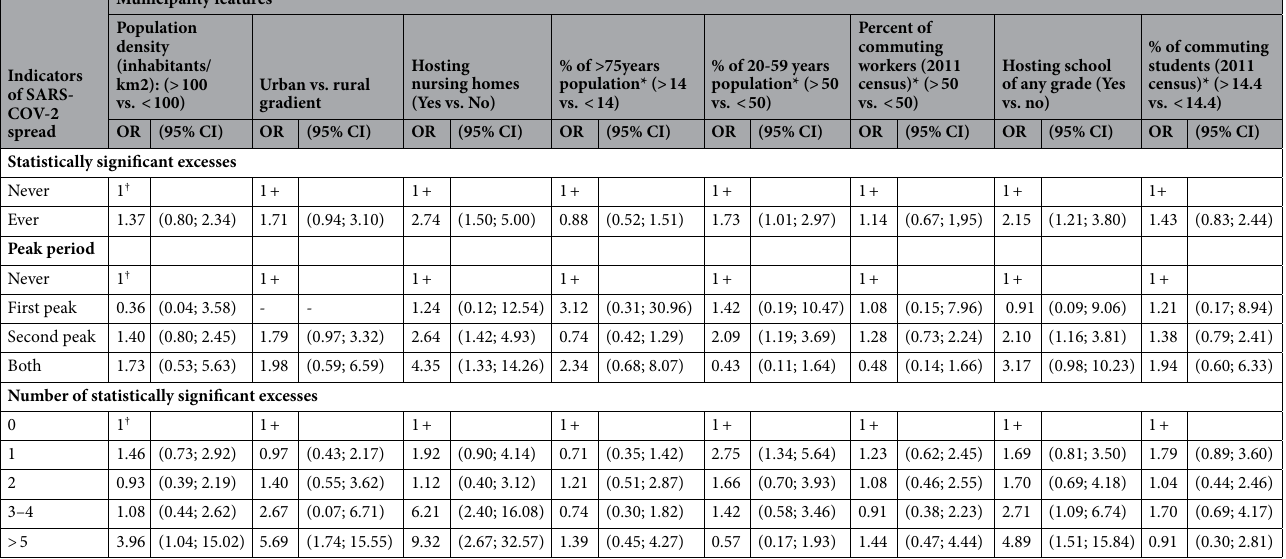
Table 2. Univariate ‡ odds ratios (OR) of eight features of the 215 municipalities of FVG region, and corresponding 95% confidence intervals (CIs), according to three indicators of SARS-COV-2 spread. FVG region, from April 1, 2020 to February 1, 2021. *To total population. † Reference category. ‡ Estimates from logistic regression.